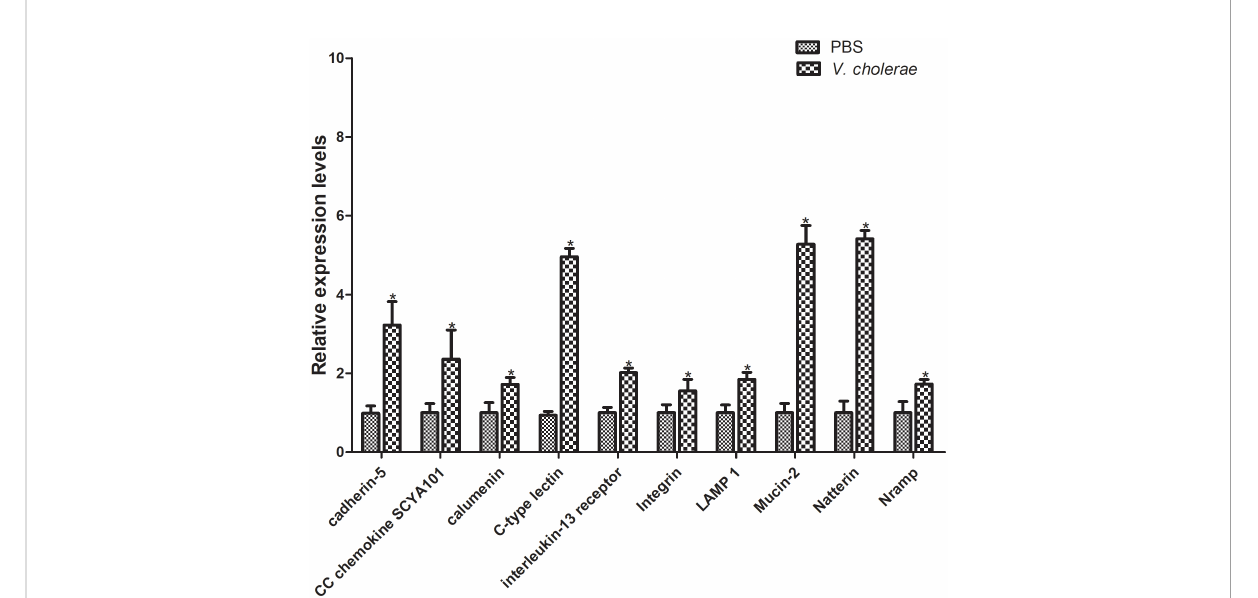
FIGURE 10 Validation of DEGs by qRT-PCR. The relative gene expression levels of 10 selected DEGs were examined. The b -actin gene was used as an internal standard. The means + SEM of three independent samples are shown (means ± SE, n = 3). Differences between treated and control samples were tested by one-way analysis of variance (ANOVA) followed by the Duncan ’ s new multiple range test. The P values are shown as * P <